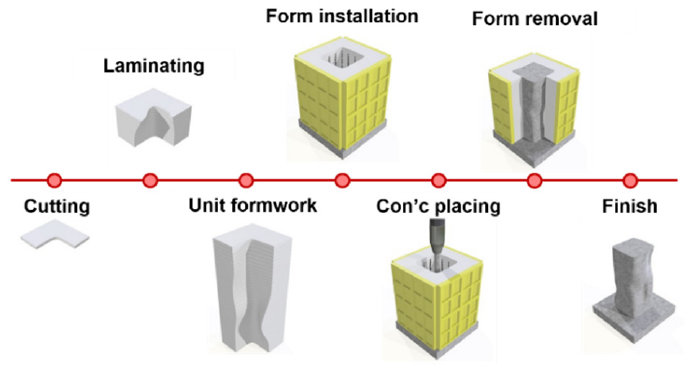
Figure 3. Manufacturing process of free-form concrete structure with EPS foam molds.